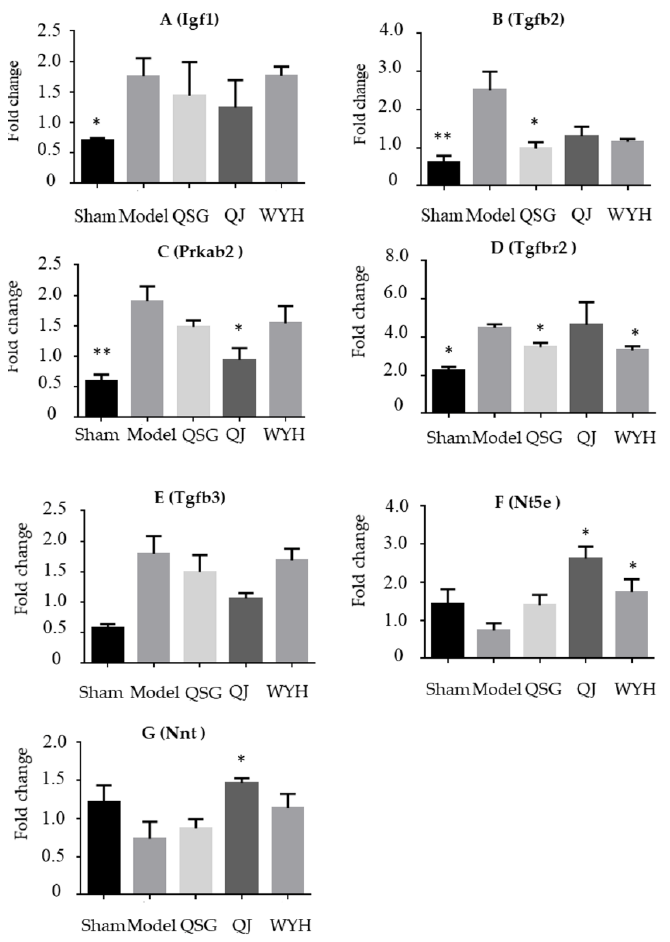
Figure 3. Gene expression in the mouse heart was determined using real-time fluorescent quantitative PCR. Values were generated by converting the estimated marginal means from the RM-ANOVA using a fold change = 2 −ΔΔCT . The expressions of ( A ) Igf1; ( B ) Tgfb2; ( C ) Prkab2; ( D ) Tgrbr2; ( E ) Tgfb3;